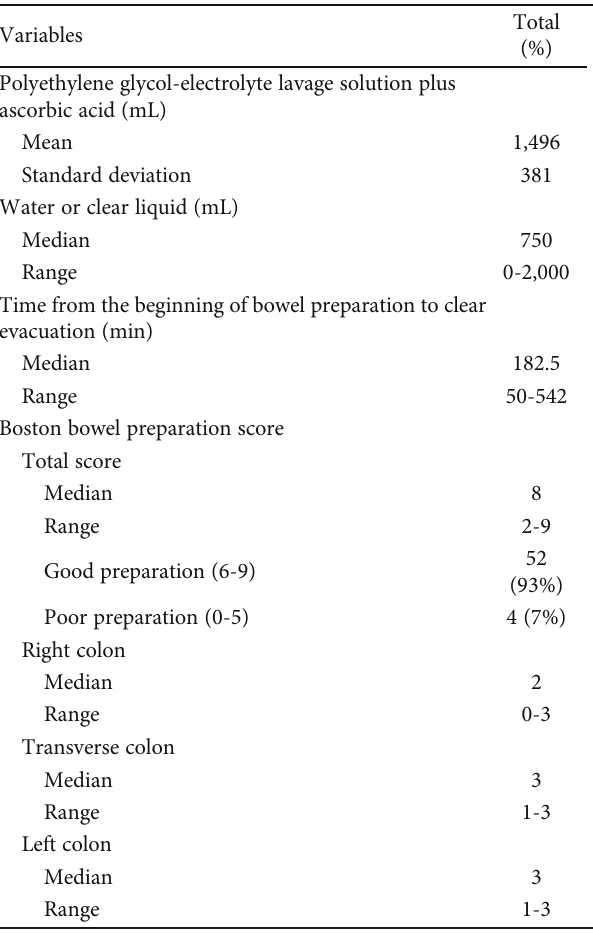
Table 3: Bowel preparation and